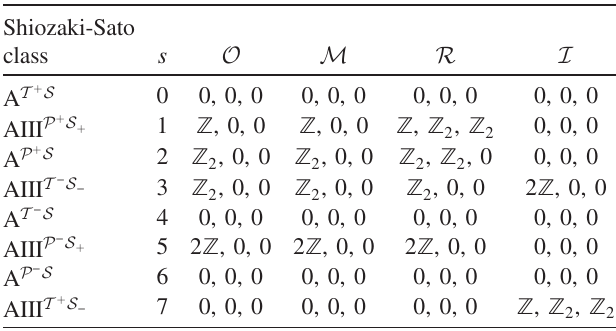
TABLE XI. Same as Table X, but for antiunitary symmetries and antisymmetries. Shiozaki-Sato